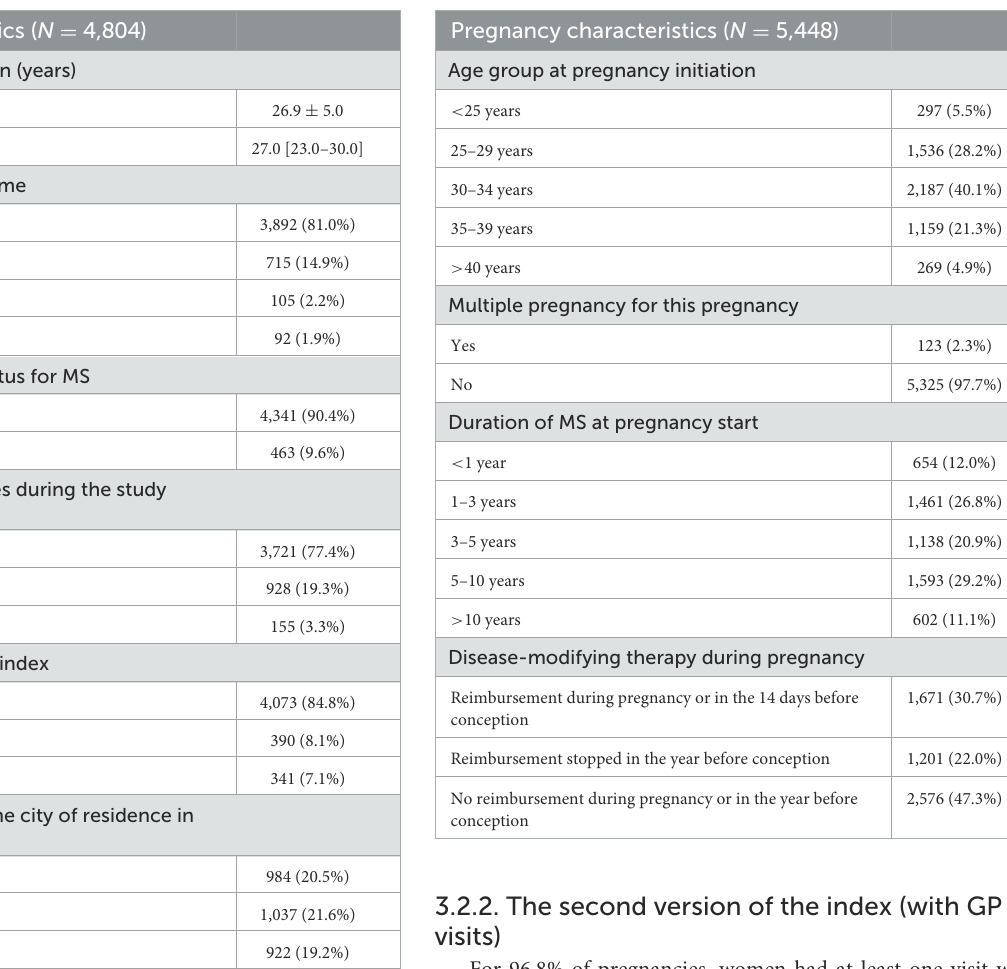
TABLE 1 Characteristics of the study population ( N =